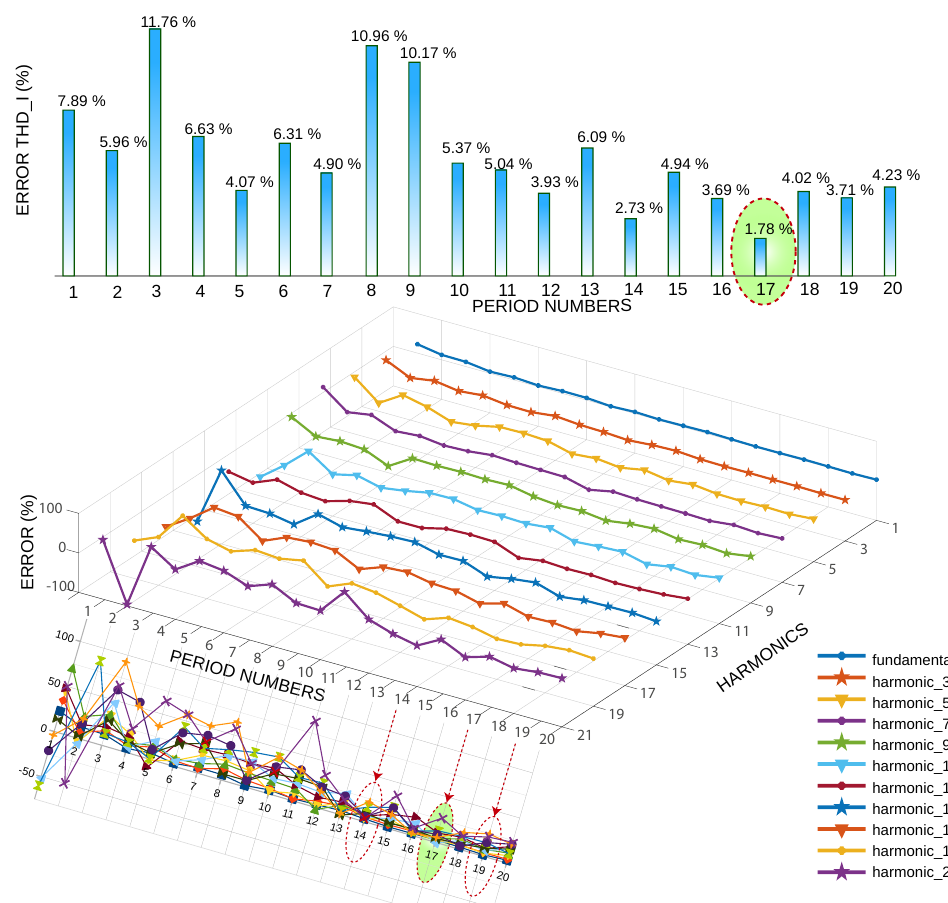
Figure 10. THD error vs. several cycles and harmonic error vs. several cycles. Figure 11 analyzes the relative error of the harmonics in the periods 14, 17, and 19, the minor error being in the fundamental frequency, and the harmonics of greater frequency are those that have a more significant error, analyzed for 17 periods; it is observed that the more substantial error is in the harmonic 21 and the minor error in harmonic